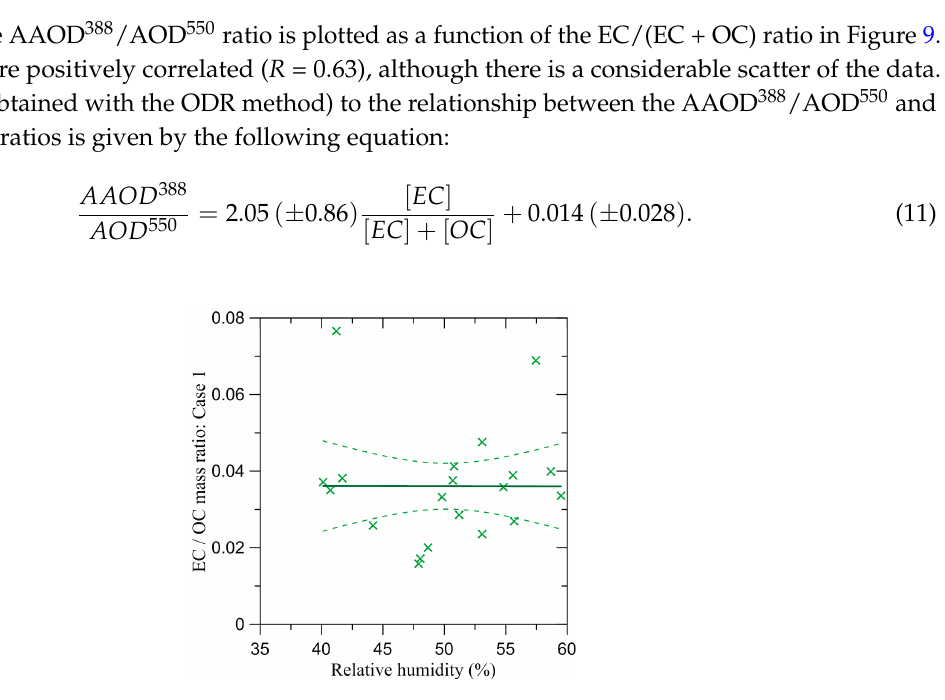
Figure 8. Case 1 estimates of the EC/OC mass ratio plotted against the ambient relative humidity in the BB aerosol columns. A linear fit (a simple linear regression) and its 90% confidence intervals are shown by solid and dashed lines, respectively.